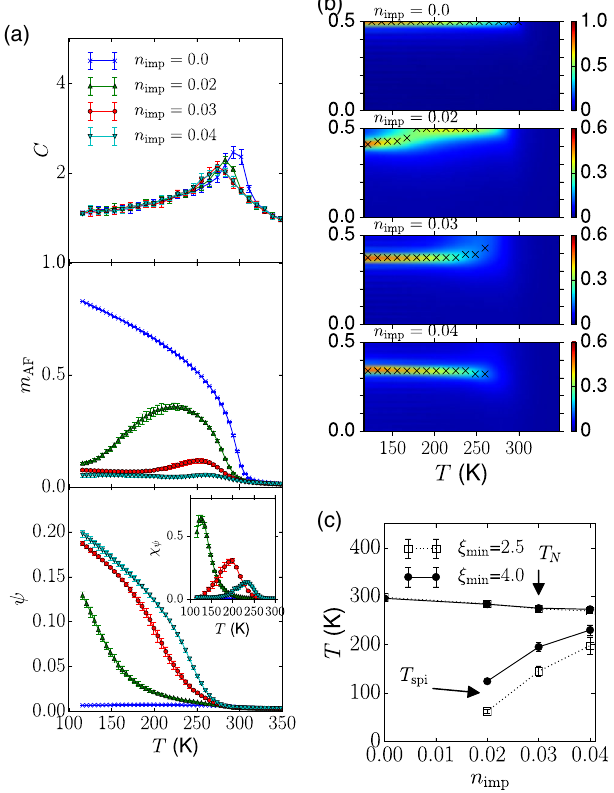
FIG. 2. Monte Carlo results obtained for systems of size L ¼ 28 . (a) Specific heat C , collinear antiferromagnetic order parameter m , and spiral order parameter ψ , which we estimated ffiffiffiffiffiffiffiffiffi p AF 4 and a range of impurity bond by computing , for ξ h ψ 2 i min ¼ concentrations. (b) Square root of the spin-structure factor S ð q c Þ 4 . The data are averaged over the in-plane computed for ξ min ¼ wave vectors. The crosses represent the wave vector at which S ð q c Þ takes a maximum value at the given temperature. The data 0 . 04 are compatible with a direct transition from for n imp ¼ the paramagnetic state into an incommensurate magnetic state < 1 = 2 . (c) Phase diagrams obtained for ξ 2 . 5 and with q min ¼ spi ξ 4 min ¼